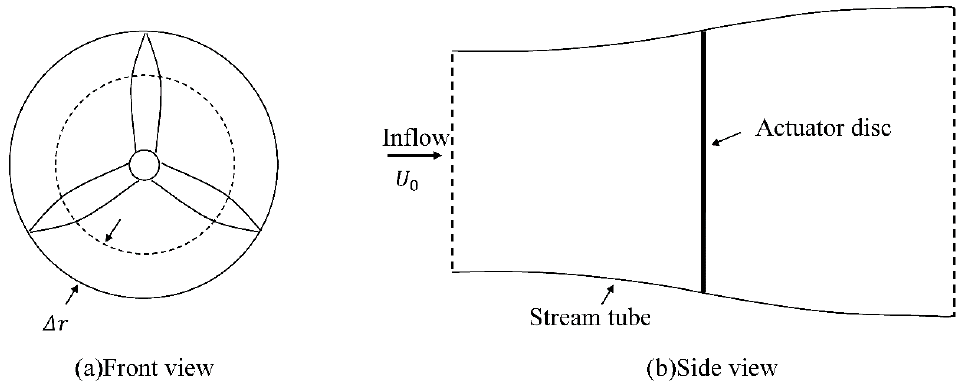
Figure 2. Schematic of the actuator disc, ( a ) front view; ( b ) side view.